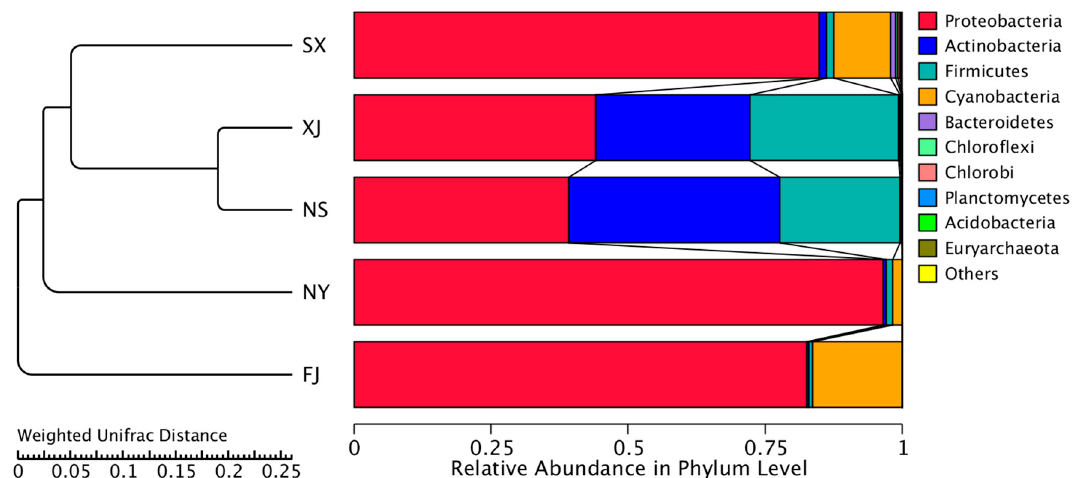
Figure 9. UPGMA clustering tree based on the weighted unifrac distance. The relative abundances of the top ten phyla in all samples are indicated, and the rest of the phyla are indicated as “Others.”